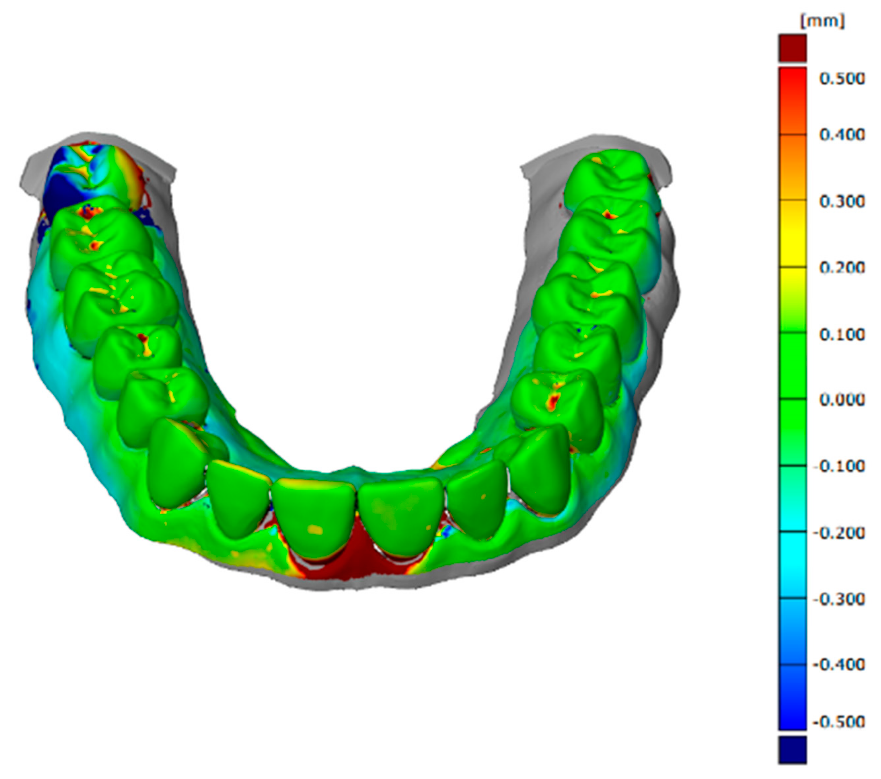
Figure 5. Deviations between the two surfaces when comparing the reference model to the addition silicone model.